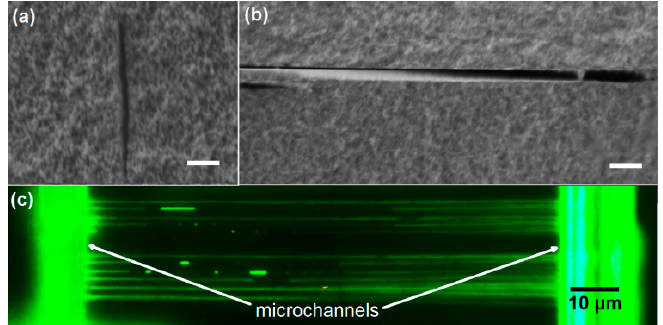
Figure 9. ( a ) Cross-section view and ( b ) top view SEM images of a single nanofluidic channel written in the porous glass. Scale bar = 300 nm; ( c ) fluorescence microscope image of the postannealed nanochannels filled with a fluorescent dye.